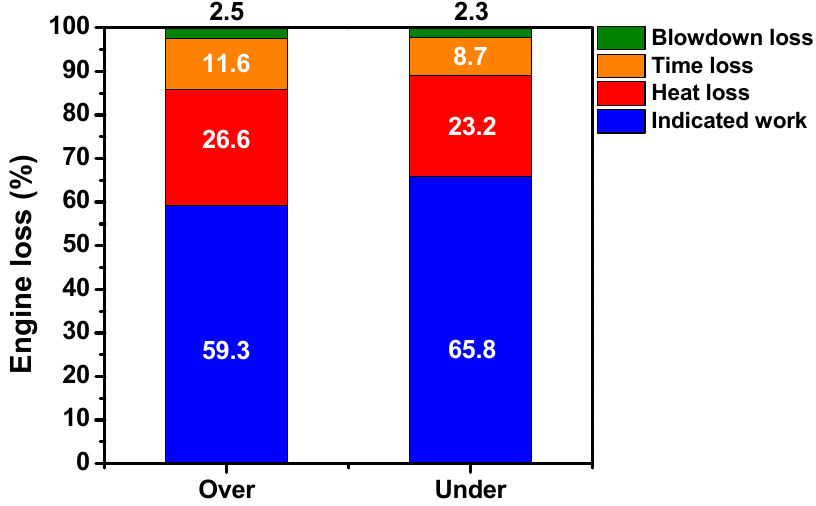
Figure 6. Three difference engine losses and indicated work for over and under square engines.